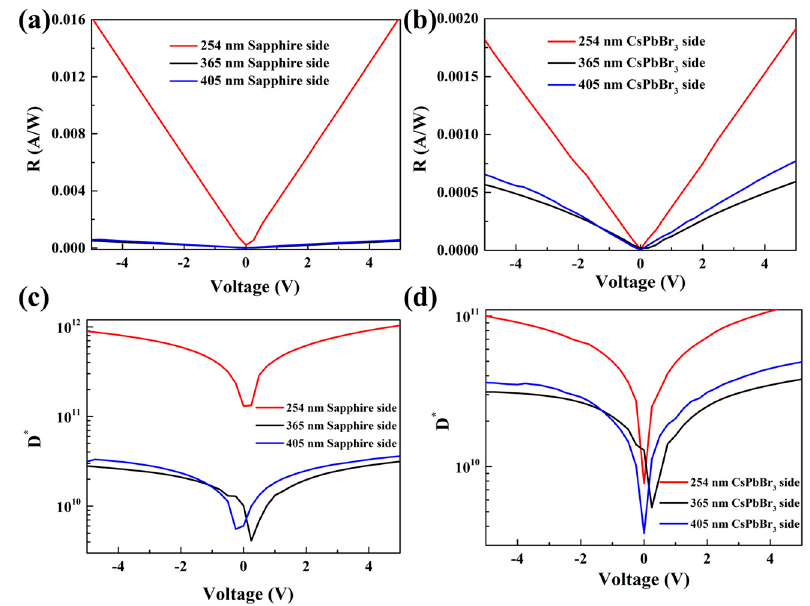
Figure 3. The responsivity ( a ) from the sapphire side and detectivity ( b ) from the CsPbBr 3 film of the Ga 2 O 3 /CsPbBr 3 heterojunction PD. The detectivity ( c ) from the sapphire side and detectivity ( d ) from the CsPbBr 3 film of the Ga 2 O 3 /CsPbBr 3 heterojunction